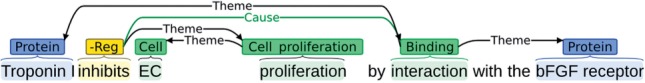
Example Negative regulation (-Reg) event connecting entities at different levels of biological organization